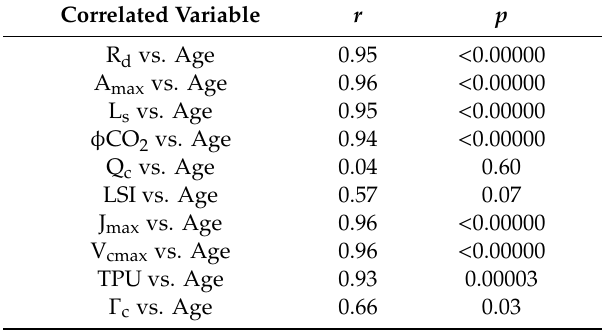
Figure 3. The light compensation point (Q c ) of hemp leaves as a function of leaf age. Cuvette O 2 was atmospheric ambient (~21%) and temperature was controlled at 25 °C. Binned averages per three-day collection sequence (means ± SE), where samples were pooled for treatments and crown position, and sample size in bins is indicated by the bubble diameter (n = 3–18 for Q c ). Solid line is a linear regression fitted to the entire data set.